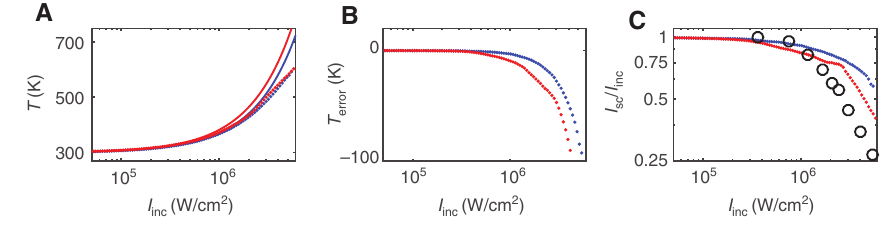
Figure 2: Temperature and intensity for intense off-resonant illumination. (A) Calculated temperature for λ = 533 nm and the off-resonance case ( ε based on annealed permittivity data. (B) Temperature difference between both models. (C) Peak intensity of the scattered field as a function of the incoming pump intensity for the two models.